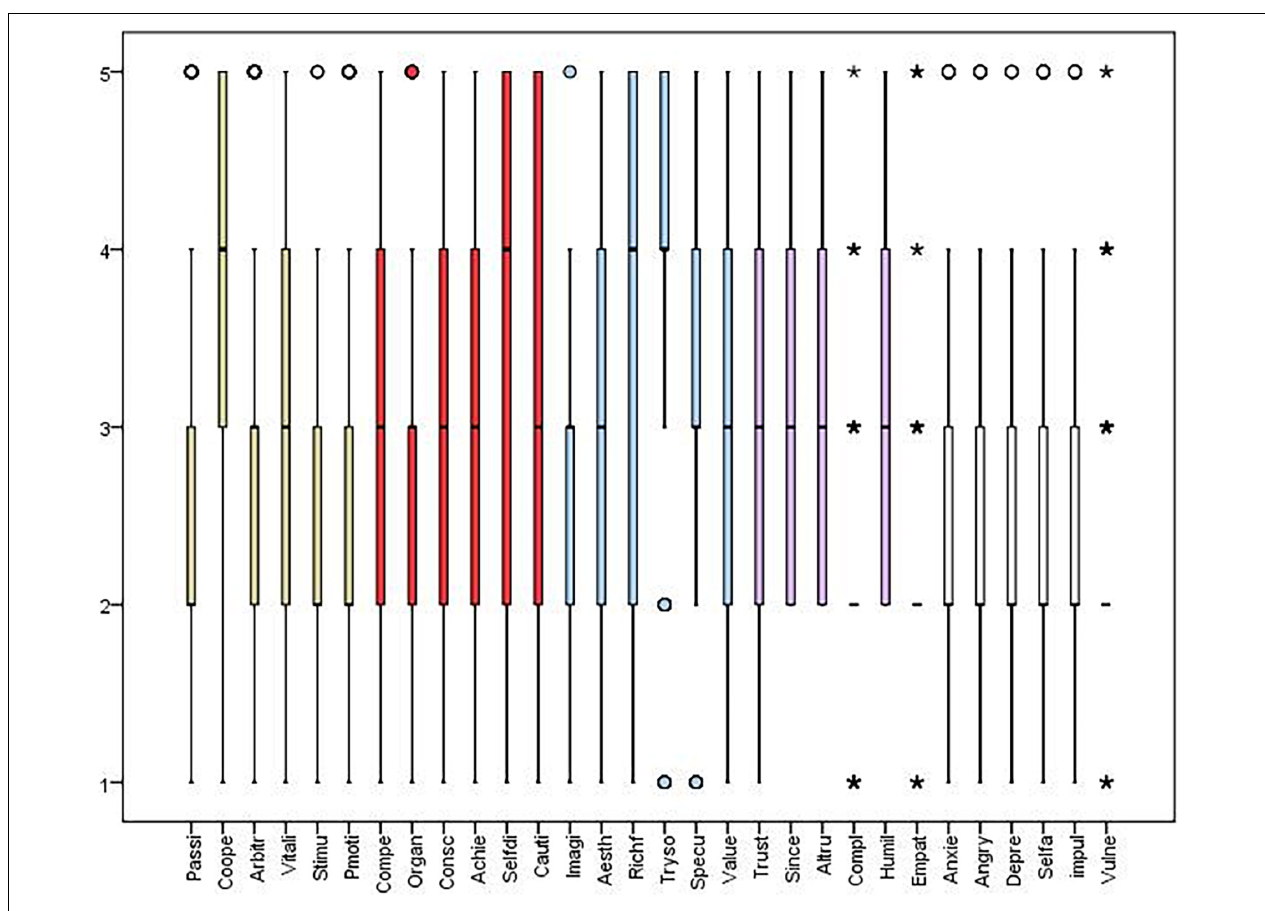
FIGURE 1 | Boxplot of personality score. “*” indicates outlier of personality